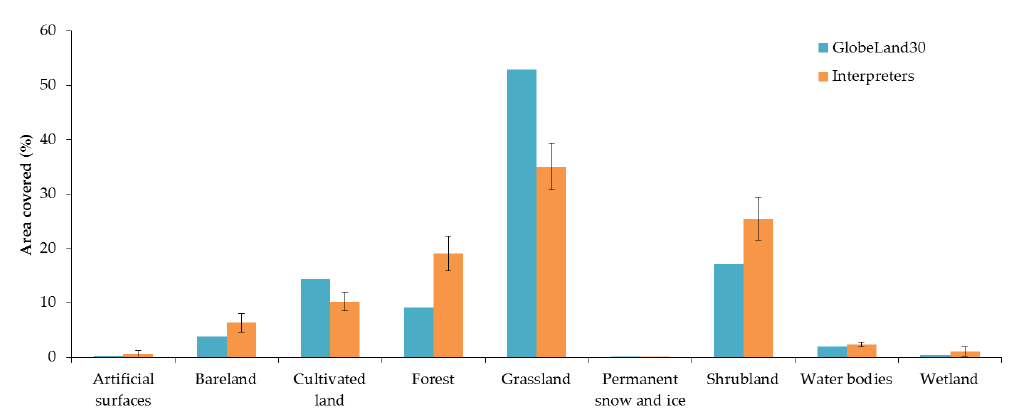
Figure 11. Comparison of the mapped area of GlobeLand30 compared to the adjusted areas based on Sample 2 (allowing for choices 1 or 2) showing 95% confidence intervals.